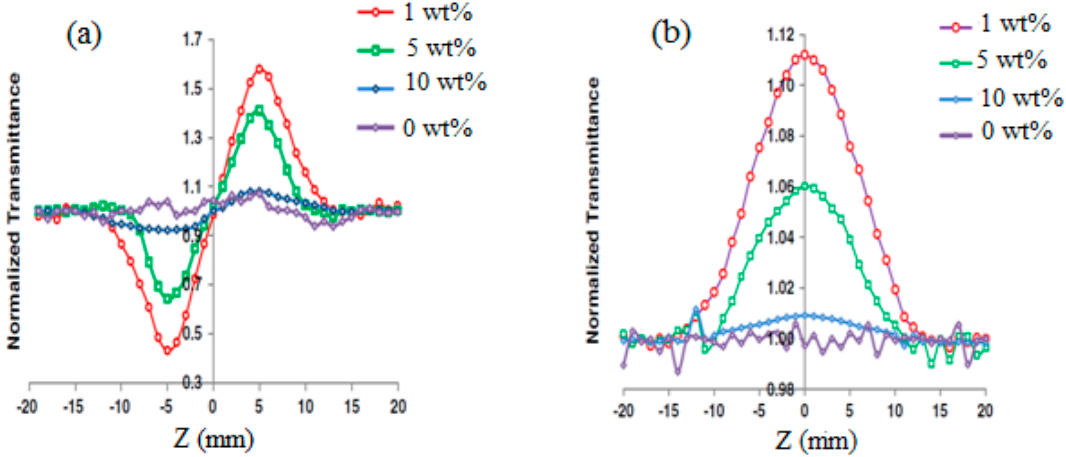
Figure 3. Curves of ( a ) close aperture and ( b ) open aperture of z-scan measurements of various concentrations of Fe 3 O 4 NPs dispersed in nematic E7 at constant intensity [44].